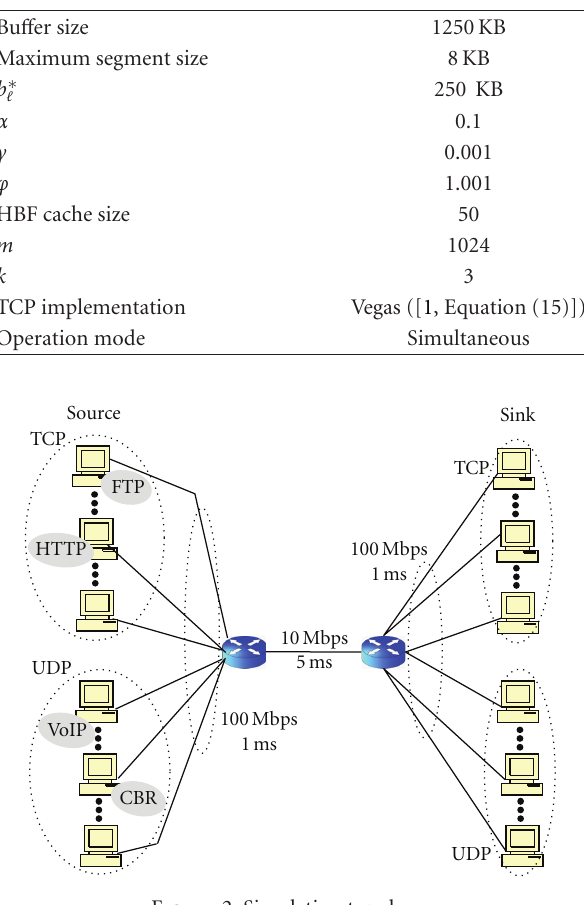
Figure 2: Simulation topology.